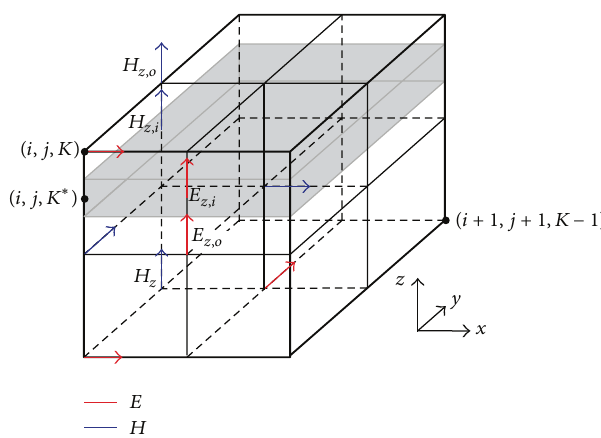
Figure 3: Modified Yeecell for subcell FDTD method at thelocation of graphene (shaded area)